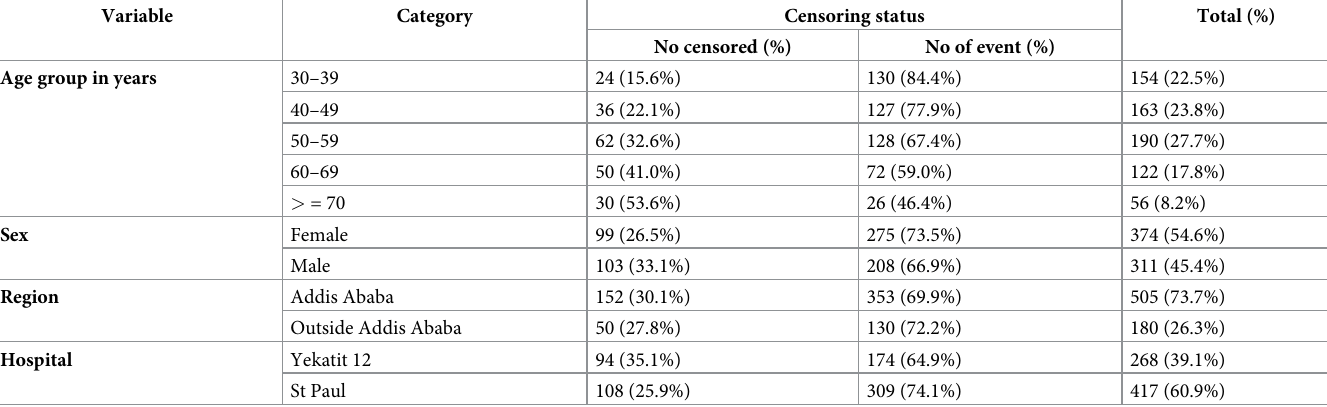
Table 1. Socio–demographic and institution related variables and censoring status among T2DM patients, Addis Ababa, 2018 (n = 685).